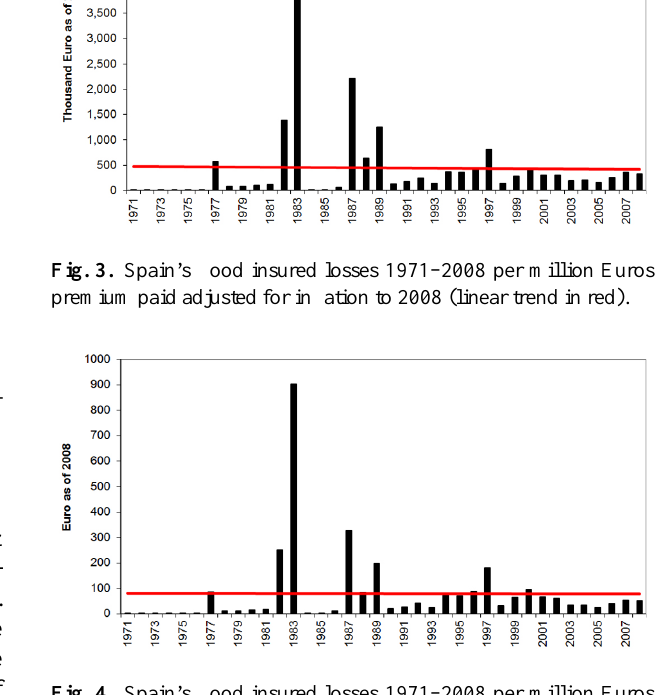
Fig. 4. Spain’s flood insured losses 1971–2008 per million Euros dwelling value adjusted for inflation to 2008 (linear trend in